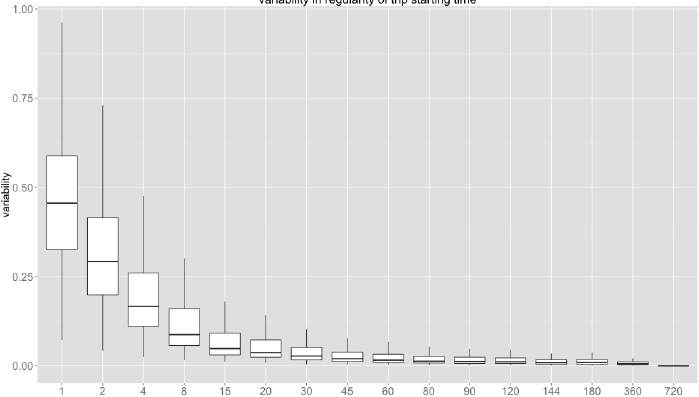
Fig 1. Variability of temporal patterns of trip starting times on the London